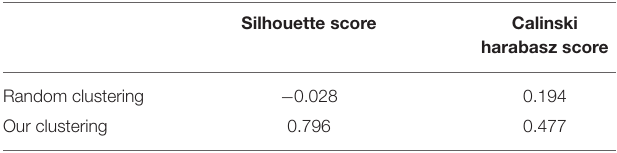
TABLE 3 | Performance comparison of our clustering and random